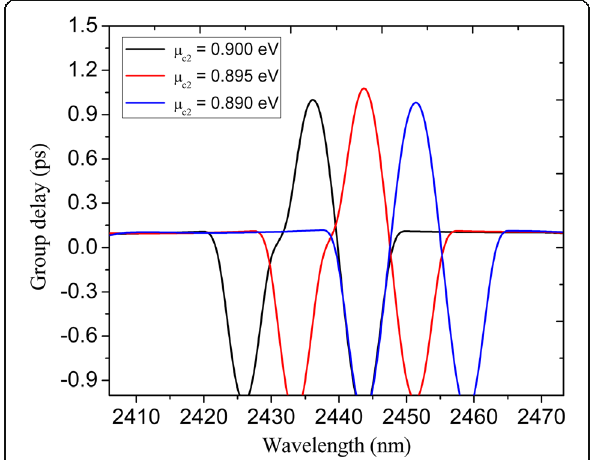
Fig. 7 The group delays versus chemical potential μ c2 for the graphene PIT system shown in Fig. 3a. The other parameters are set as W =800 nm, L =620 nm, d =20 nm, W U =150 nm, L U =120 nm,